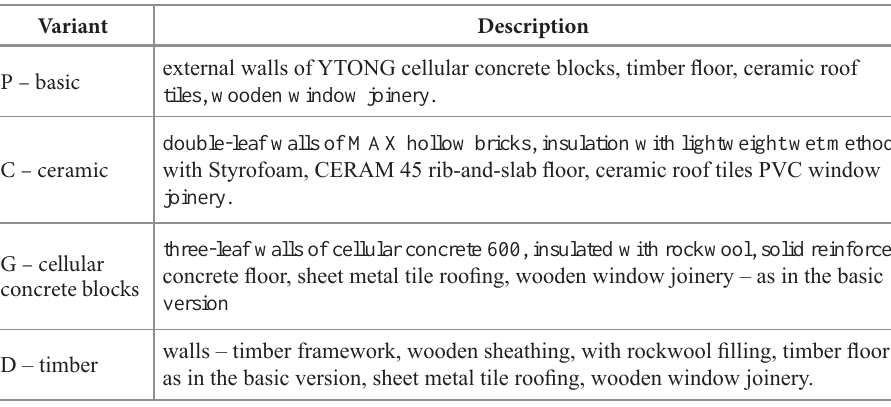
Table 1. The list of residential building variants Variant